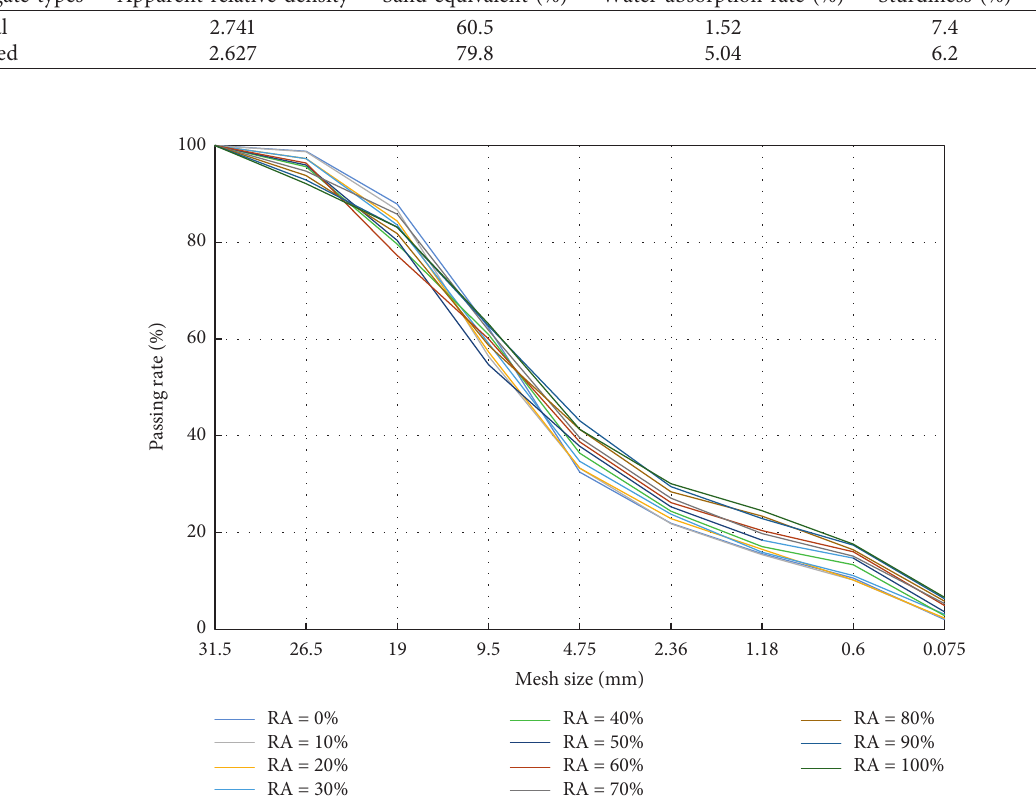
Figure 1: Grading curve.